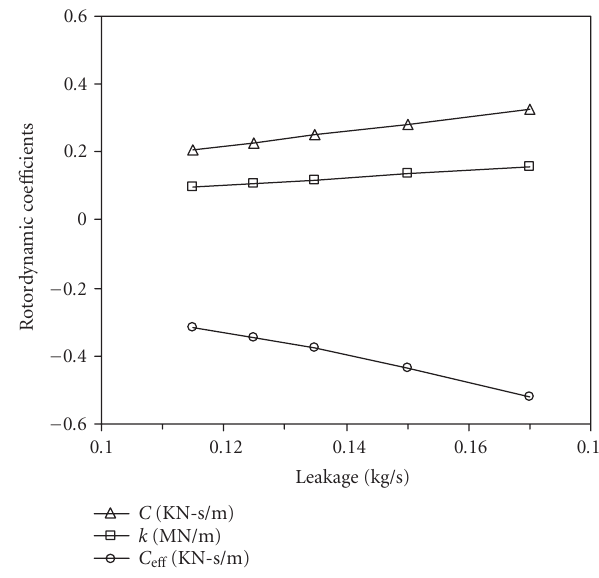
Figure 12: Axial distribution of swirl velocity within a high-low labyrinth seal: high portion, D-E; low portion, F-G. (5) The substantial influence of swirl variation along the rotor on seal rotordynamics is suggested to explain the large sensitivity di ff erences of seal rotordynamics caused by the rotor axial shifting.